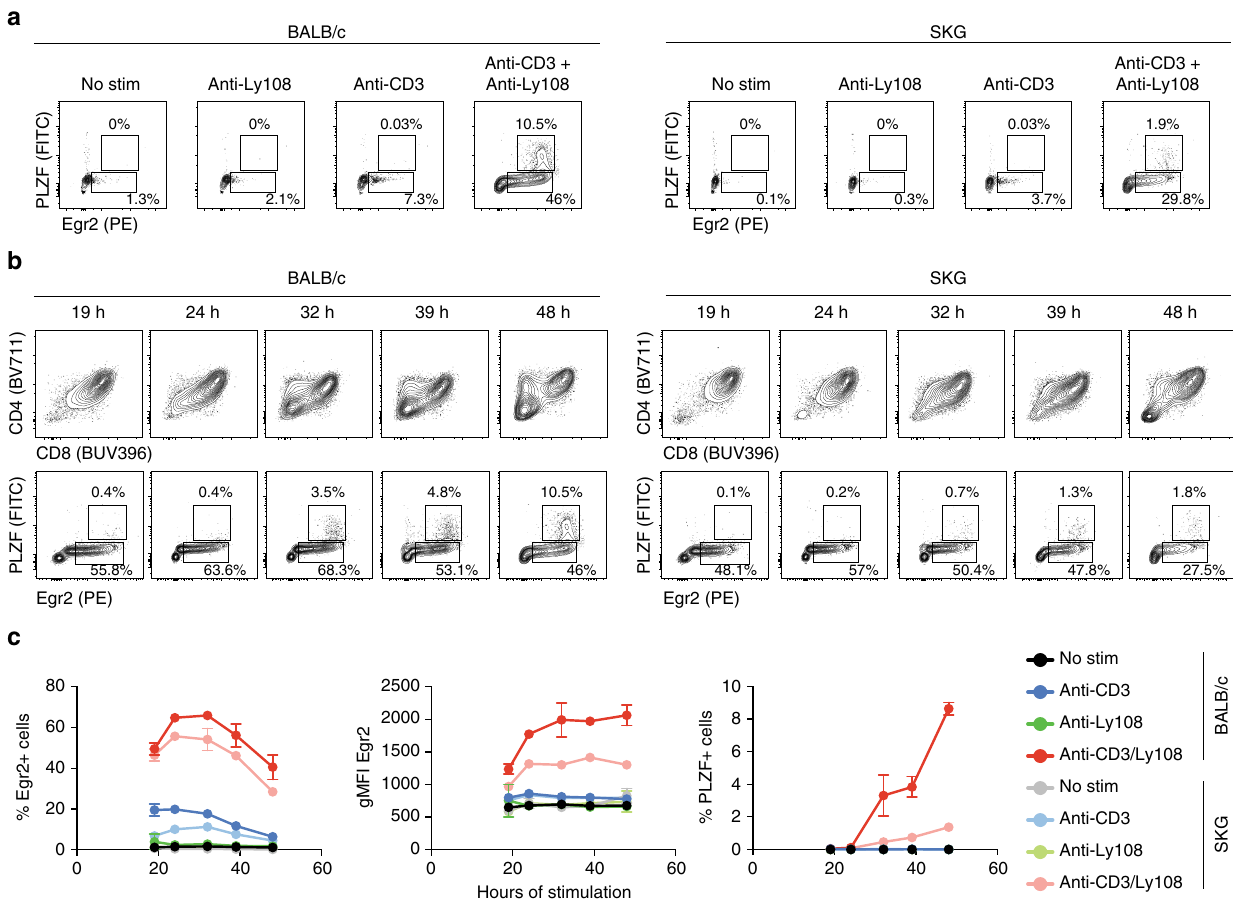
Fig. 6 Induction of Egr2 and PLZF in pre-selection DP thymocytes stimulated with plate-bound anti-CD3 and anti-Ly108 mAbs is affected by the SKG mutation. a Expression of Egr2 and PLZF proteins in pre-selection BALB/c or SKG DP thymocytes stimulated with media alone (no stim), plate-bound anti- CD3, anti-Ly108, or anti-CD3 + anti-Ly108 for 48 h. At the end of the stimulation, cells were stained using anti-CD4, -CD8, -Egr2, -PLZF mAbs, and a viability dye. The percentages of live cells that are Egr2 + and PLZF + are indicated for each stimulatory condition. b Time course of CD4, CD8, Egr2, and PLZF expression in pre-selection BALB/c or SKG DP thymocytes stimulated with plate-bound anti-CD3 + anti-Ly108 mAbs. Data are shown for live cells in each conditions. c Summary of the data shown in b for each stimulatory condition. The percentage of Egr2 + cells, the gMFI of Egr2 expression, and the percentage of PLZF + cells are shown. Each experimental condition was tested in duplicate wells and the data are representative of greater than three independent experiments with similar